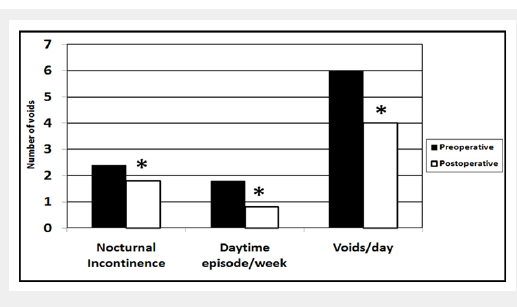
Figure 2 Incidence of nocturnal enuresis, daytime enuresis and voids per day in 33 enuretic children with SDB pre- and postoperatively ( * p <0.05 =